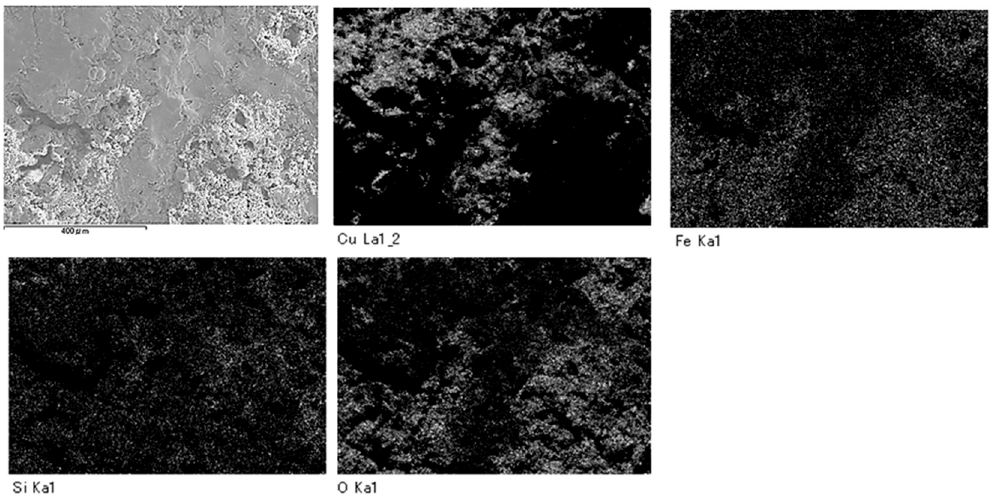
Figure 13. Element mapping images of Cu-coated coupons after LBR-immersion testing.